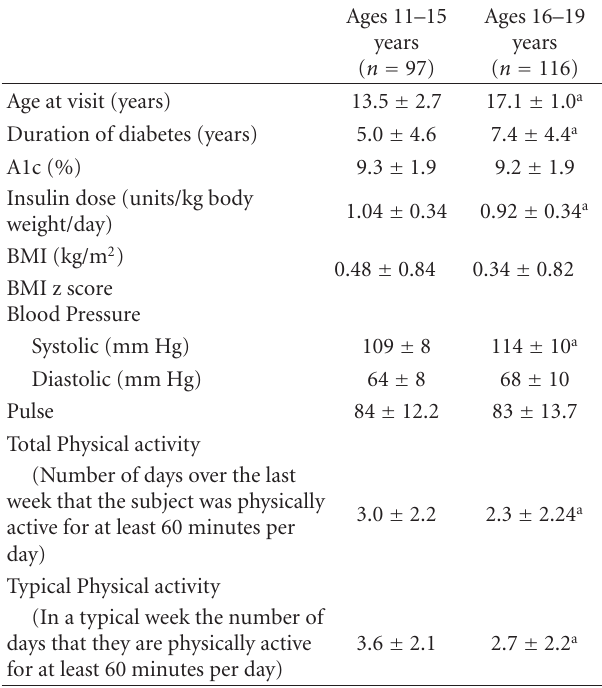
Table 2: Level of physical activity by age